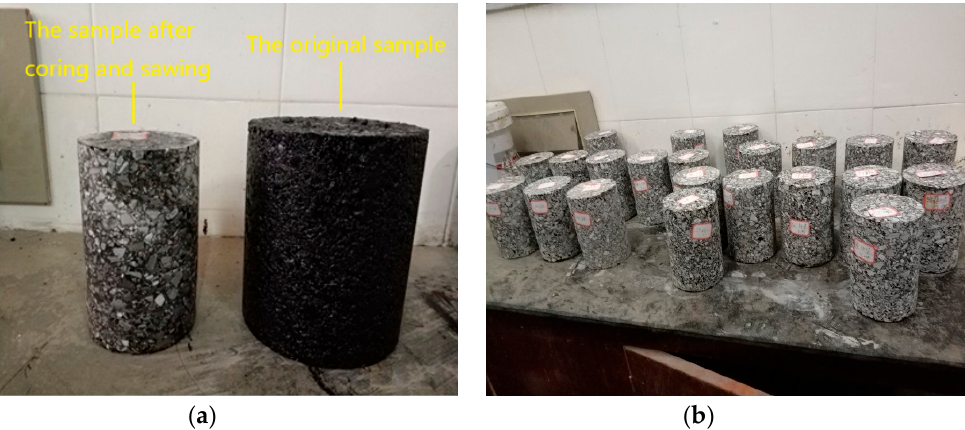
Figure 3. Demonstration of samples: ( a ) the original SGC sample and the sample after coring and sawing; ( b ) the SPT samples.